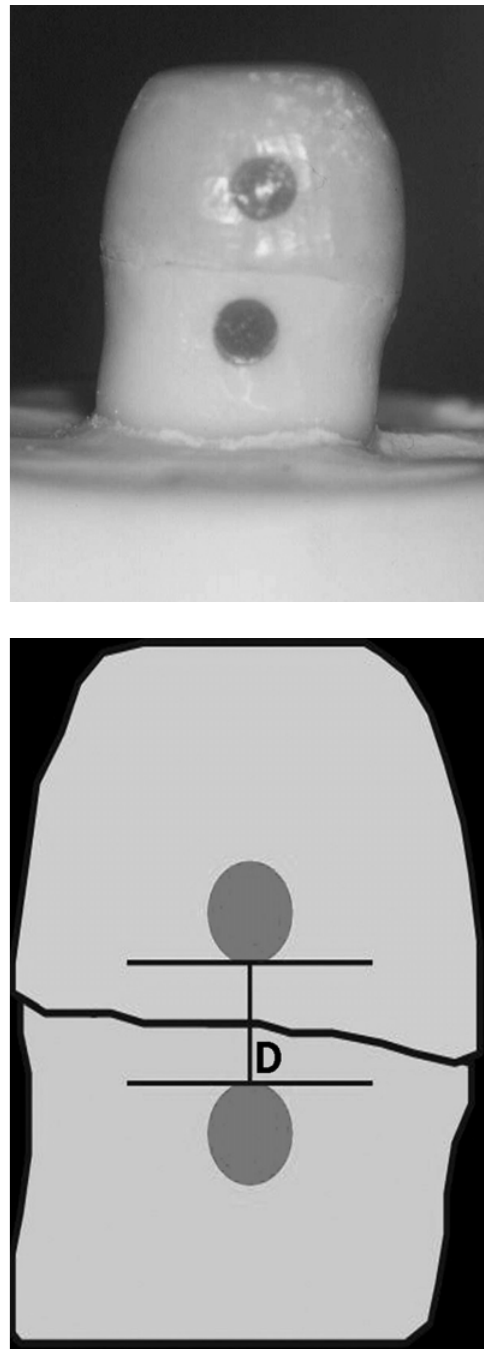
FIGURE 2- Provisional restoration with circular marks (upper panel). Marginal openings obtained before and after cementation were achieved by the distance (D) between the internal tangents of the two circular marks (lower